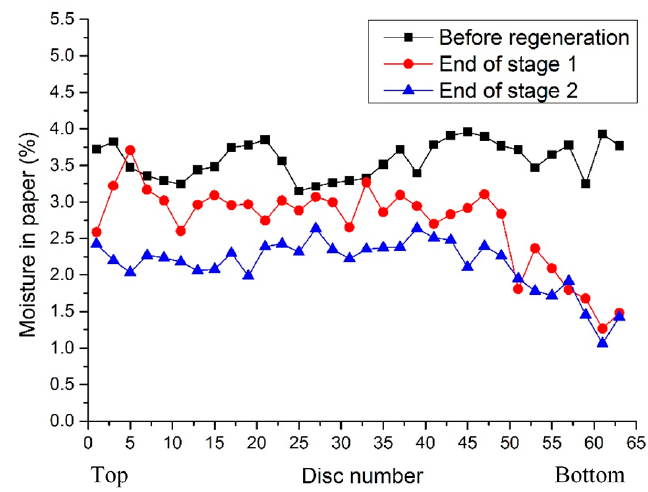
Figure 8. Profile of moisture in paper before regeneration, at the end of stage 1, and the end of stage